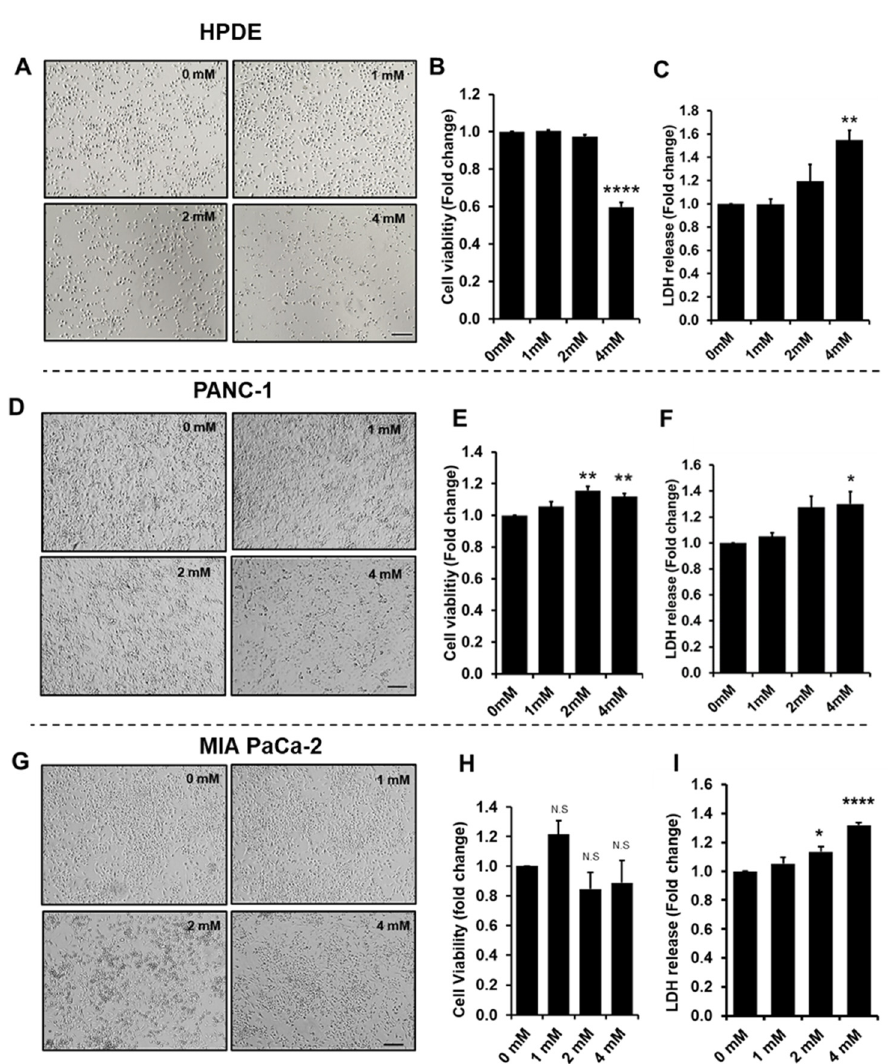
Figure 1. HPDE, PANC-1, and MIA PaCa-2 cells treated with glyceraldehyde for 48 h. ( A , D , G ) Bright field images of cells treated for 48 h with glyceraldehyde. Scale bar: 200 µ m. ( B , E , H ) Cell viability determined by MTT assay. ( C , F , I ) Cell damage determined by LDH assay. Absorbance or fluorescence values were normalized to control (0 µ M). Data represent the mean ( n = 3) ± SE. N.S, not significant, **** p < 0.0001, ** p < 0.01, * p < 0.05 vs. control (0